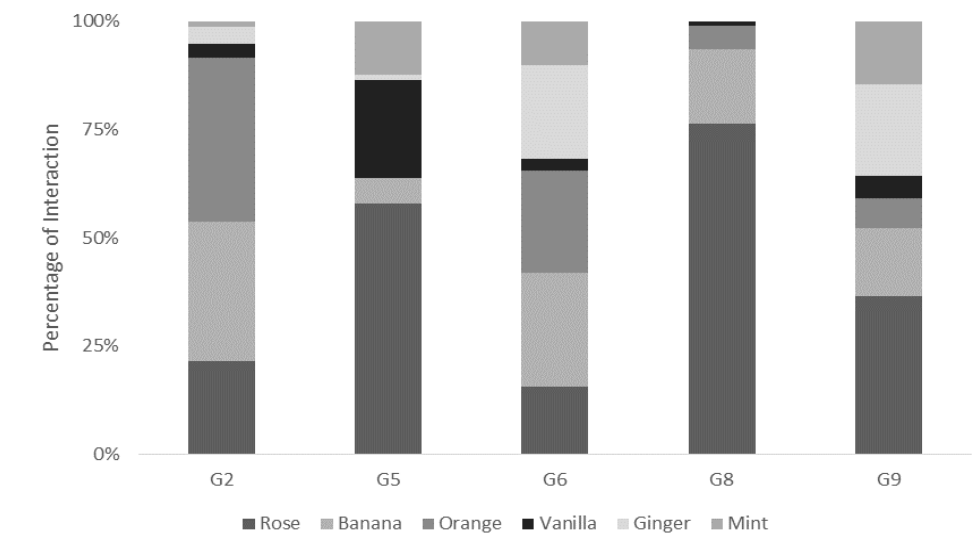
Figure 3 . Differences in duration and number of bouts spent with each of the different